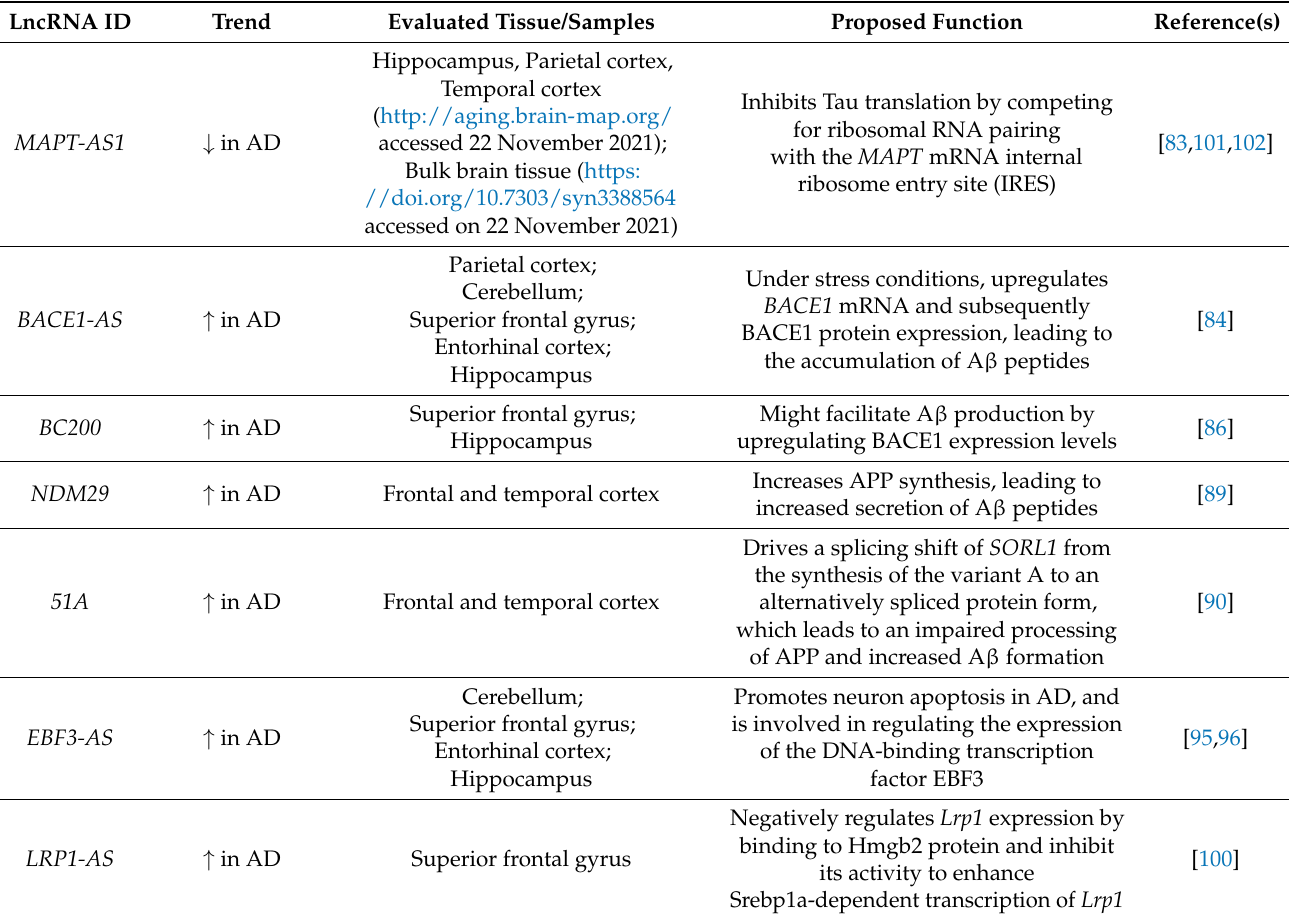
Table 2. Examples of deregulated lncRNAs in brain tissue samples from patients with